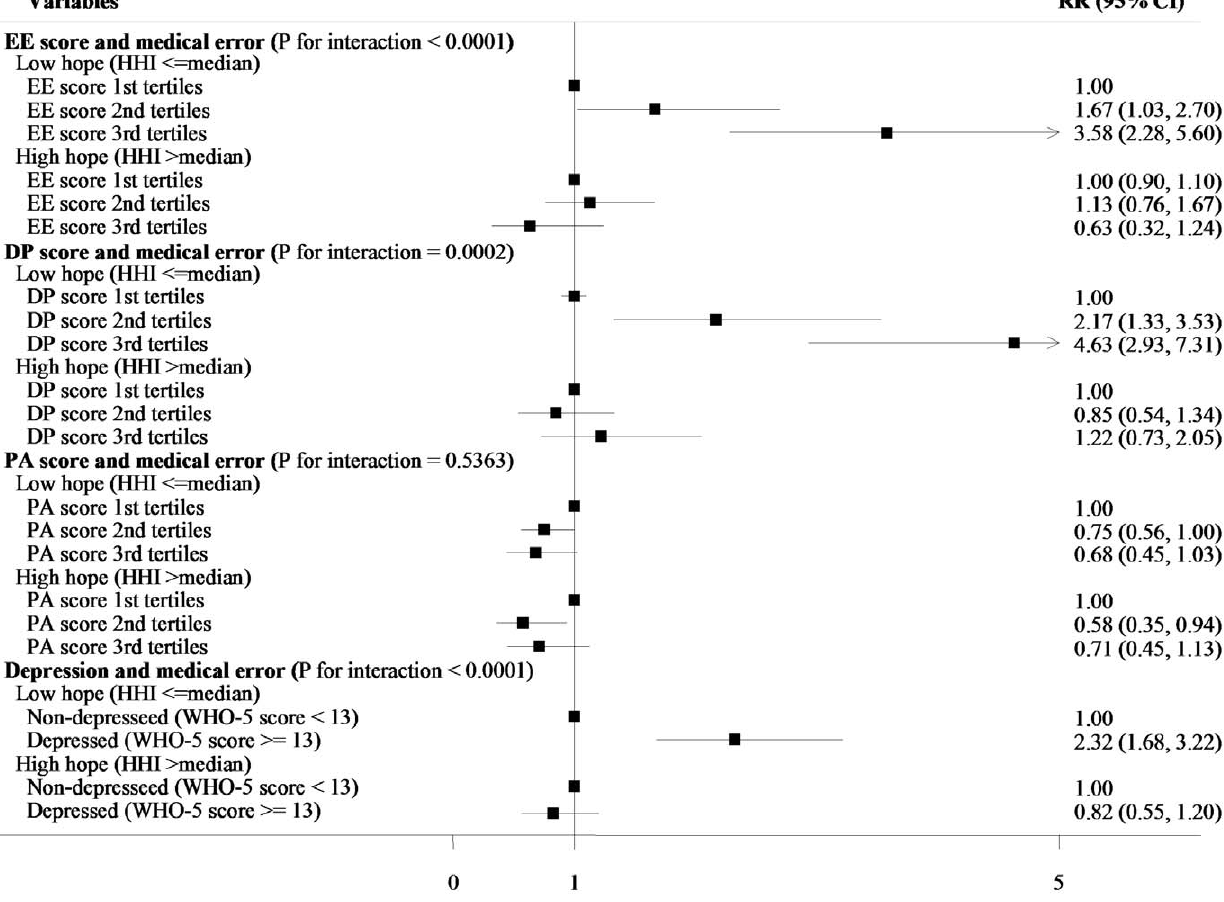
Figure 1. Association between burnout and medical errors: subgroup analysis by depressive symptoms evaluated by WHO-5 or Herth Hope Index score among practicing physicians, males and females, 2009. WHO-5, World Health Organization-Five Well-being Index; HHI, Herth Hope Index; IRR, Incidence rate ratio adjusted for age and sex.